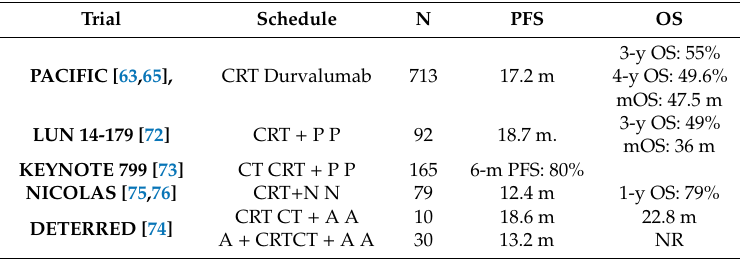
Table 6. Summary of the e ffi cacy of immune checkpoint inhibitors in stage III